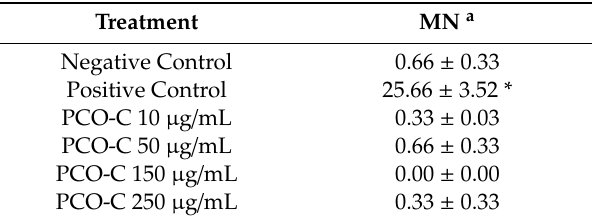
Table 4. E ff ects of di ff erent concentrations of PCO-C on the in vitro micronucleus tests after 24 h of Table 4. Effects of different concentrations of PCO-C on the in vitro micronucleus tests after 24 h of treatment of human peripheral blood treatment of human peripheral blood lymphocytes.